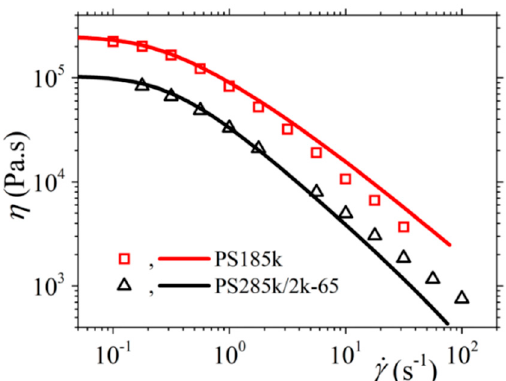
M = 285 kDa and polymer volume fraction 64.9% (PS285k/2k-65) at 160 °C characterized by τ d = 5.32 s and η 0 = 1.04 × 10 5 Pa.s.